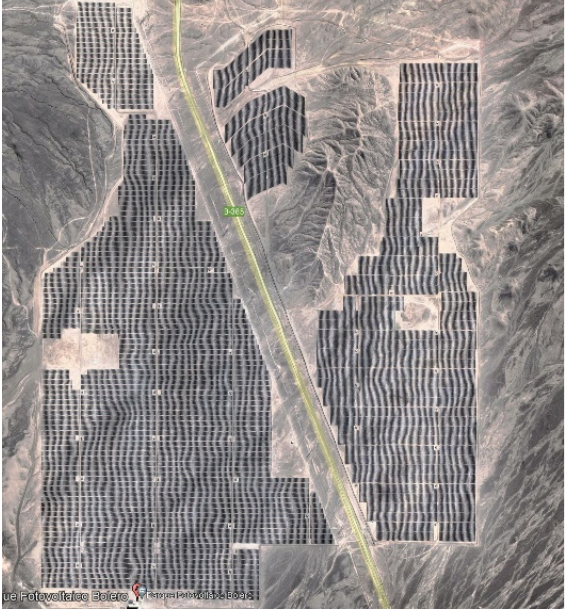
Figure 4. Bolero Photovoltaic Park, Sierra Gorda, Antofagasta, Chile [38].